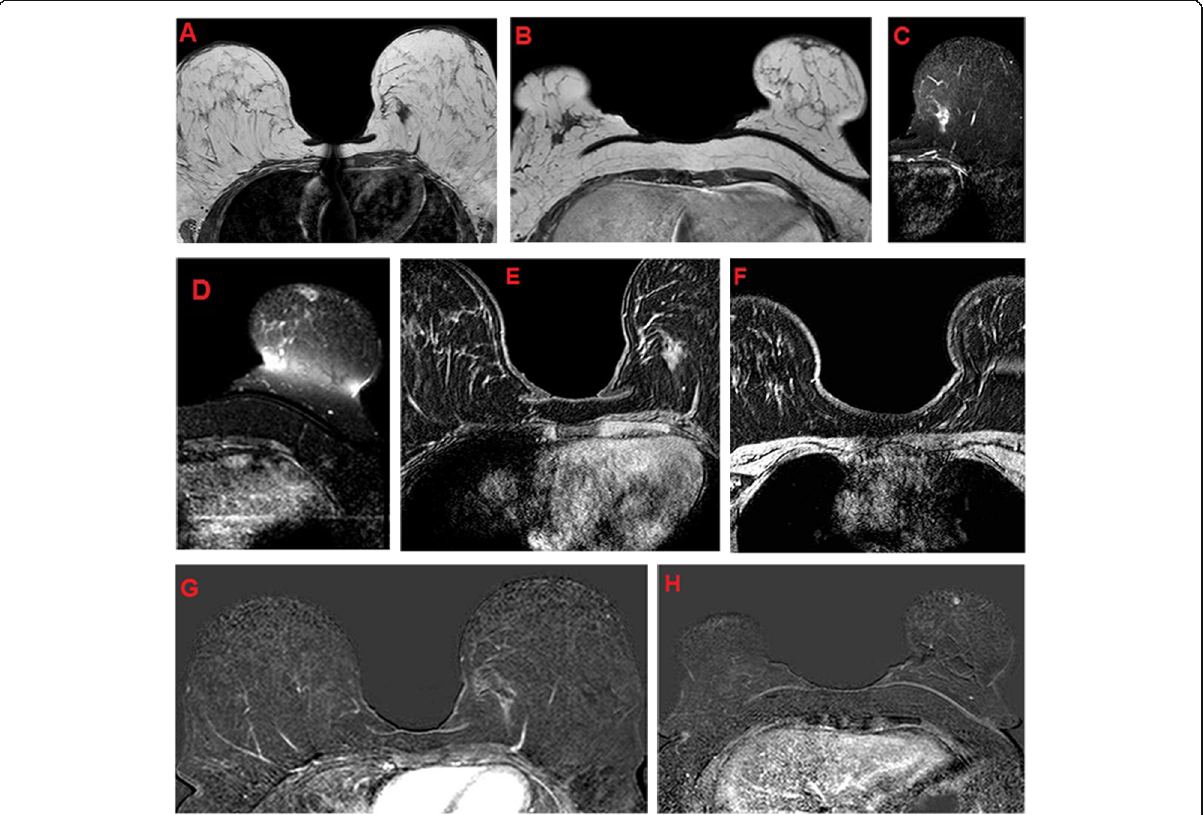
Fig. 2 MR images: a , b T2. c , d STIR. e , f DCE-MRI post-contrast. g , h DCE-MRI subtraction images. Left LIQ lesion “ arrow ” eliciting intermediate T2 and high STIR signal intensity and showing focal non-mass enhancement on dynamic post-contrast images. Another left lower central small rounded mass with a circumscribed margin “ arrowhead ” eliciting intermediate T2 and STIR signal intensity shows homogenous enhancement in post-contrast images The pathology revealed TN invasive ductal